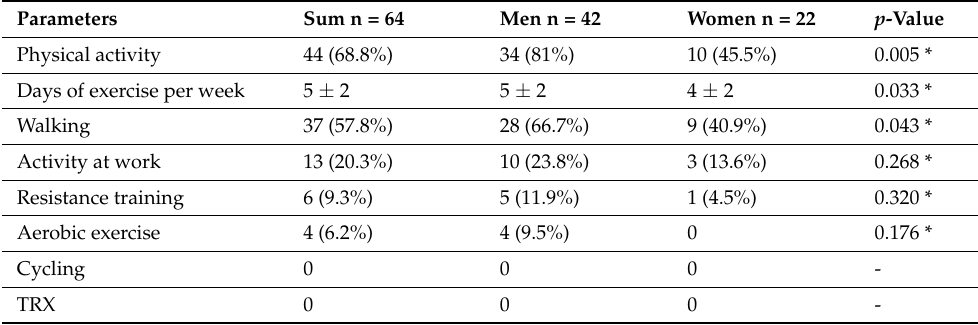
Table 5. Post-hospitalization physical activity of the study’s population and their comparison based on sex n =